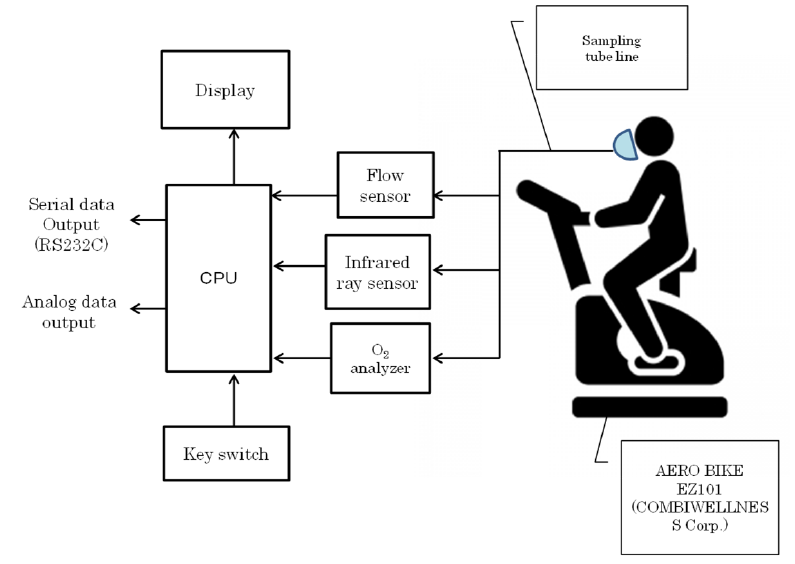
Figure 3. Experimental protocol.